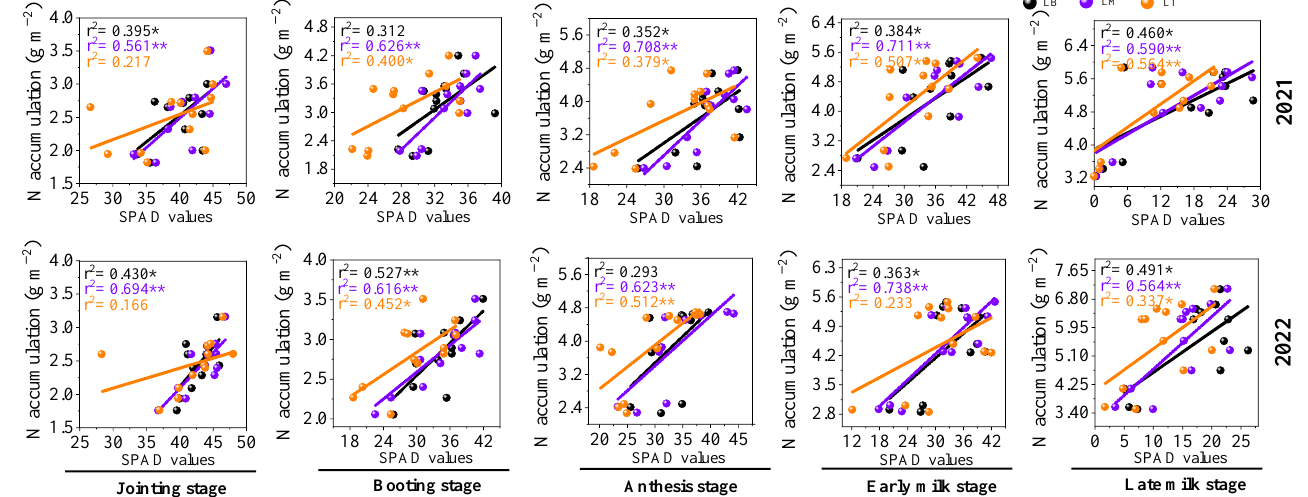
Figure 2. The relationship between SPAD values of different leaves and N accumulation of plant. * and ** indicate significant differences at 0.05 and 0.01 levels, respectively. L1, L2, L3, and L4 indicate the first top leaf, second top leaf, third top leaf, and fourth top leaf of the wheat, respectively. L1, L2, L3 and L4 are represented by black, purple, yellow and gray respectively.